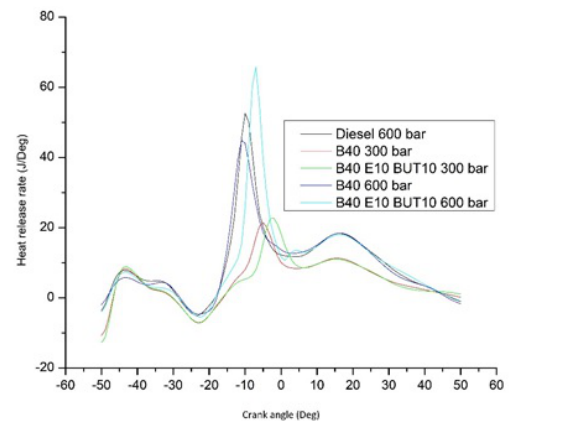
Fig. 8. Net heat release with Crank